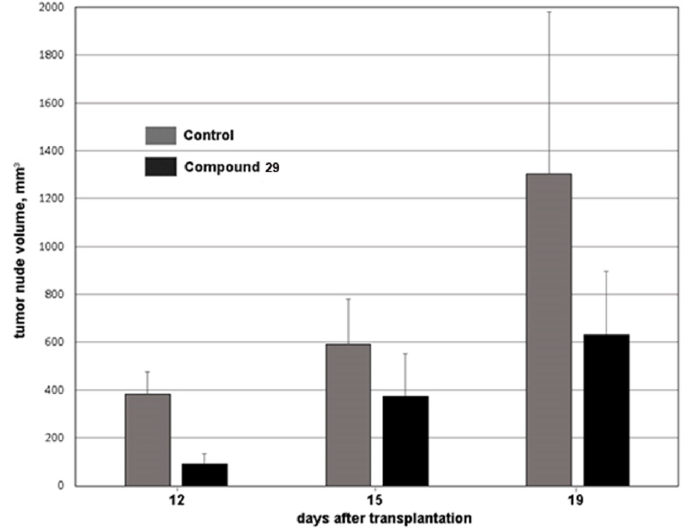
Figure 9. Changes in P388 volume upon the treatment with compound 29 (1176 mg/kg, o.d., 10 days, i.p.).